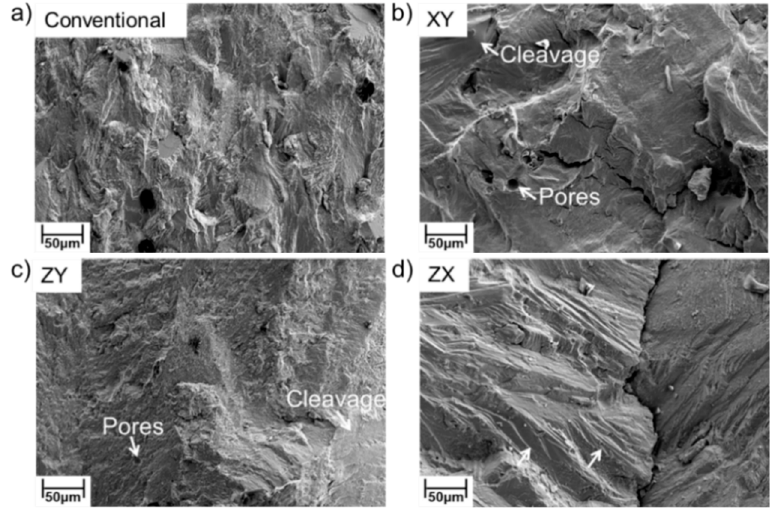
Figure 12. Fracture surfaces of ( a ) conventional and LPBF-manufactured specimens of build directions ( b ) XY, ( c ) ZY, and ( d ) ZX.